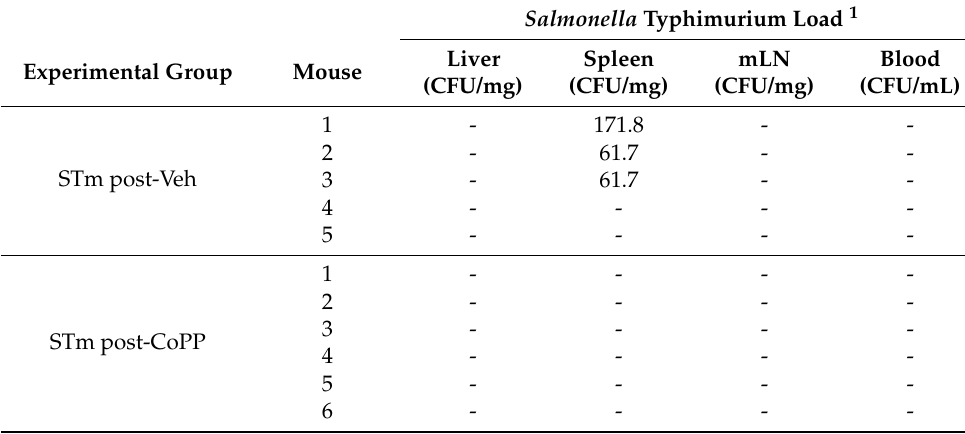
Table 2. S. Typhimurium load in mice organs after post-infection treatment with